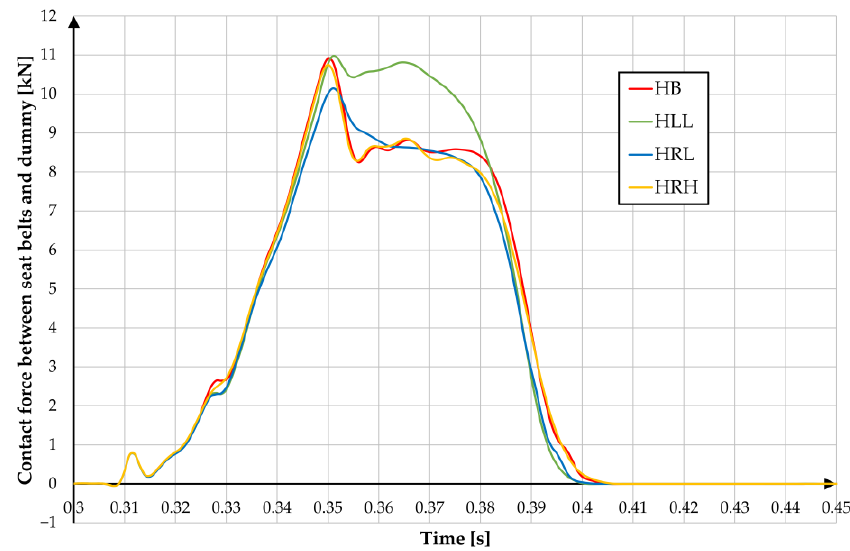
Figure 15. Comparison of contact force between the seat belts and the dummy. In group C (Figure 16), no loss of strength after the dummy starts to contact the airbag is visible in two cases — CBL and CLL.